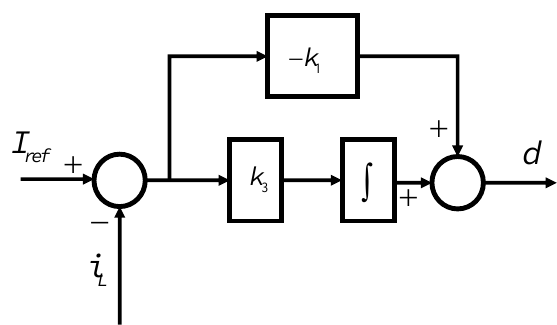
Figure 7. The proposed control law can be understood as a modified single current loop PI controller, with PI parameters − k 1 and k 3 .